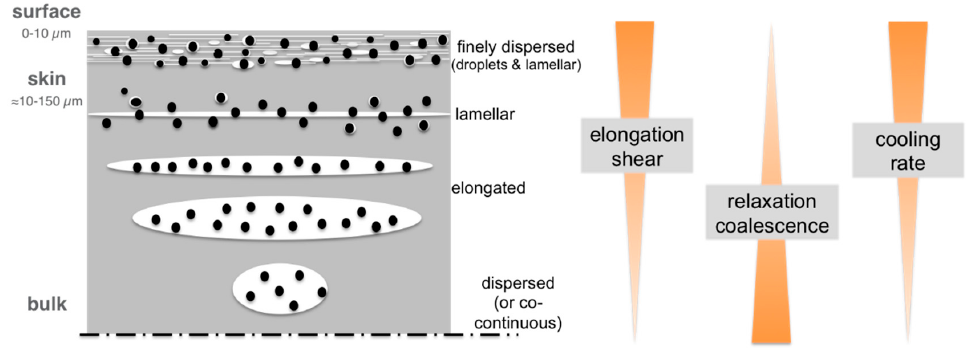
Figure 10. Illustration of morphology formation during injection molding of PC/ABS blends.